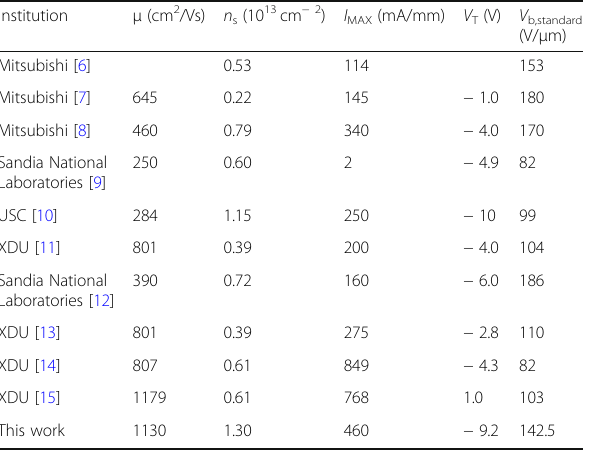
Table 1 Core indexes of AlGaN channel HEMTs (heterostructures) in previous reports and this